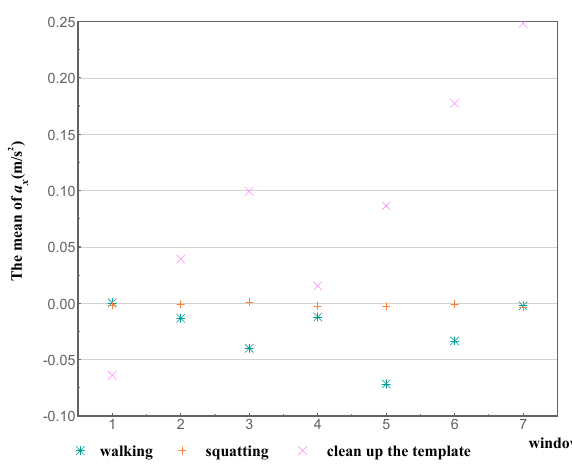
Figure 9. Scatter plot of mean for walking, squatting, and cleaning up the template.